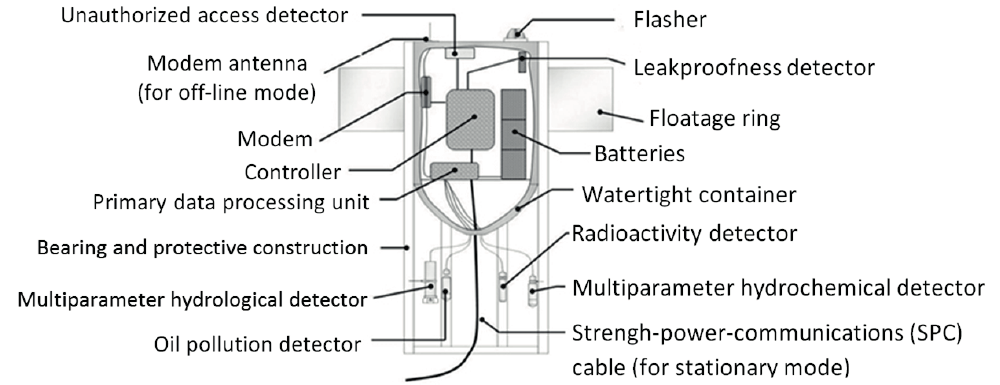
Fig. 9 Automated monitoring station (AMS) in sectional